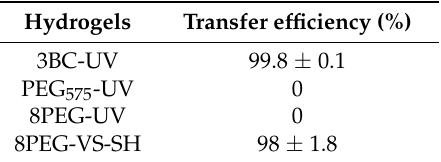
Figure 3 . SEM images of Au NPs on the surface of ( a1 ) 3BC-UV hydrogels; ( b1 ) PEG575-UV hydrogels; ( c1 ) 8PEG-UV hydrogels; ( d1 ) 8PEG-VS-SH hydrogels and silicon wafers, after the transfer procedure ( a2 – d2 ). Table 2 . Transfer efficiency of Au NPs from silicon wafers to 4 different hydrogels.